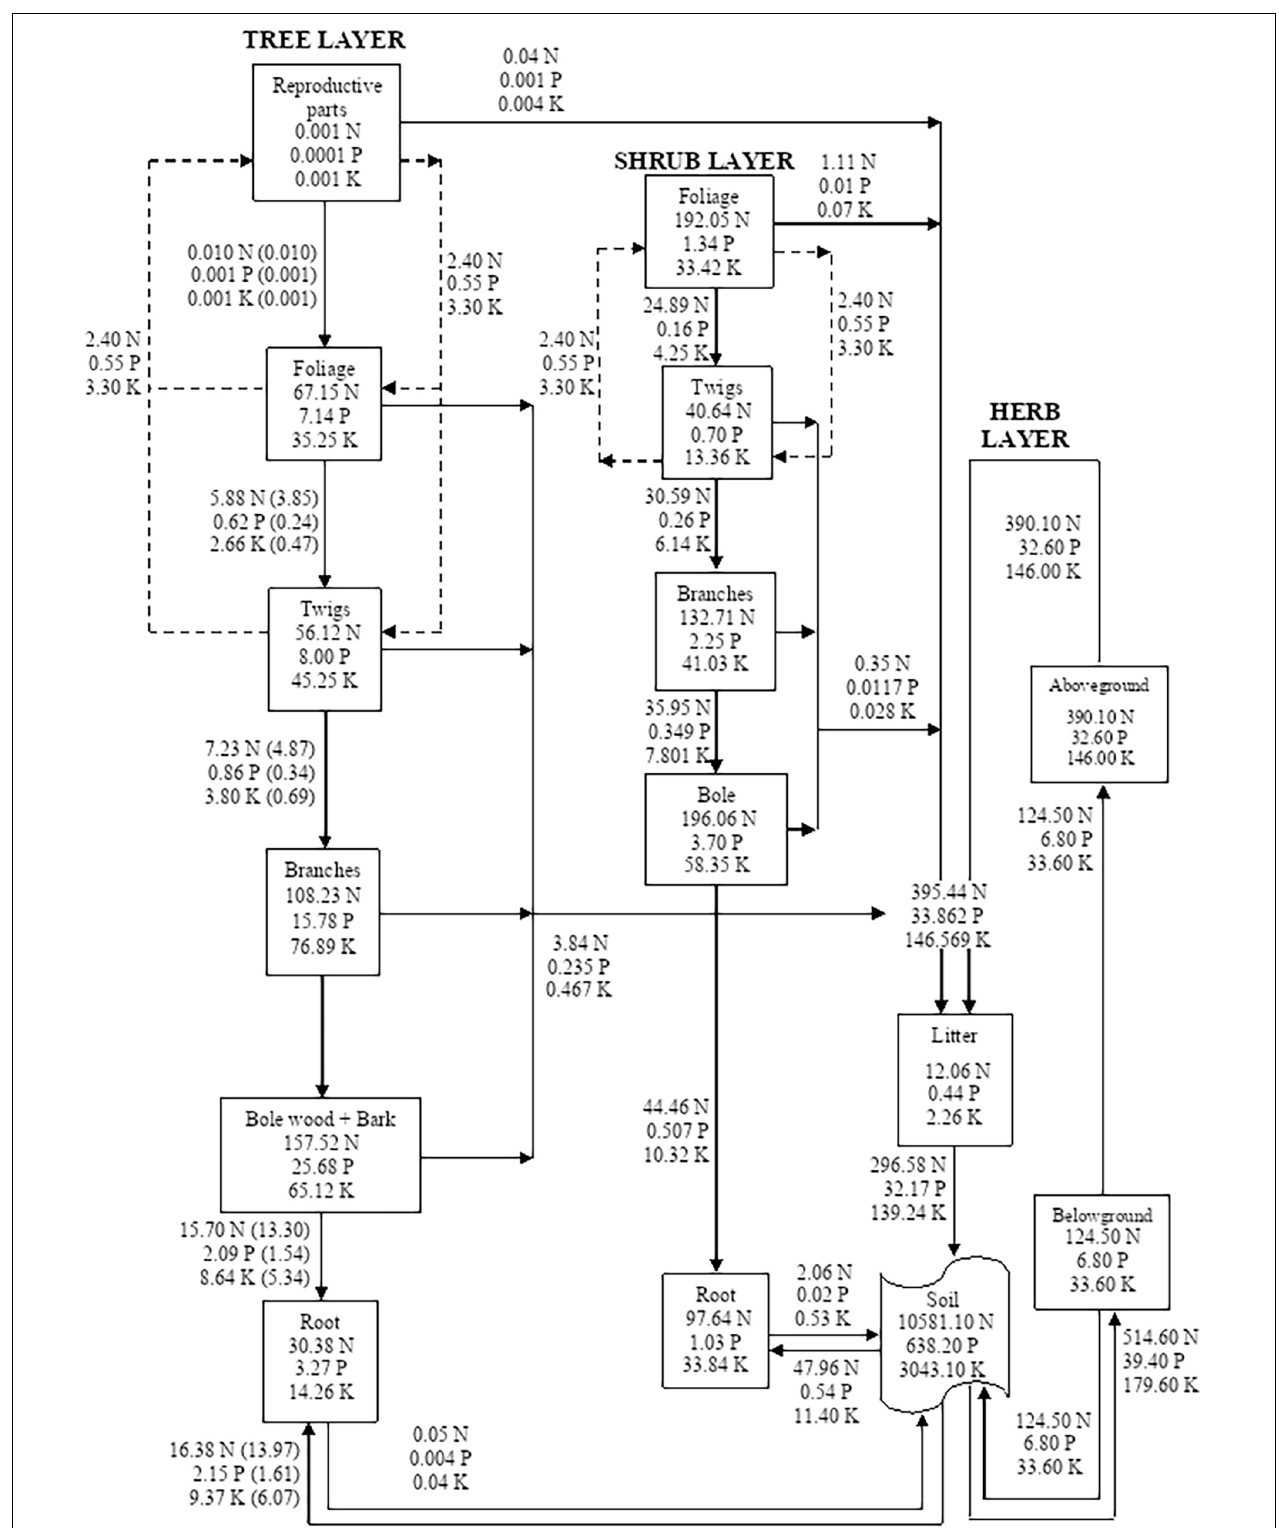
FIGURE 4 | Compartment models showing the distribution and cycling of nitrogen (N), phosphorus (P), and potassium (K) in tree, shrub, and herb at site-4. Rectangle represents a compartment for standing state of nutrients from one compartment to the next compartment. Units are kg ha − 1 yr − 1 for flows between compartments. Values in parenthesis are after adjustment for internal cycling. Recycling between reproductive parts, foliage, twigs, and bole is shown by dotted lines.